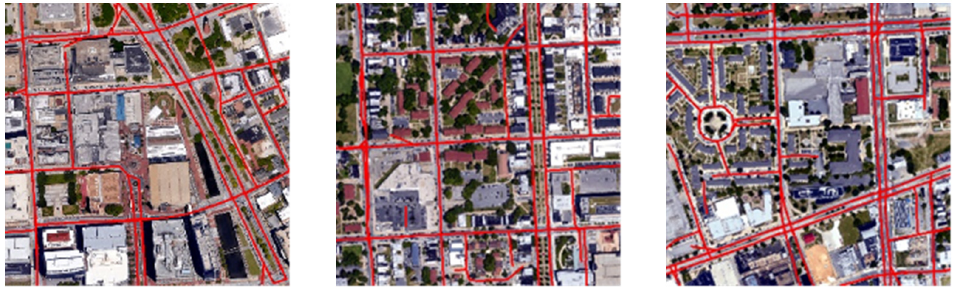
Figure 10. Visualization results of the proposed Bi-HRNet on RoadTracer dataset.